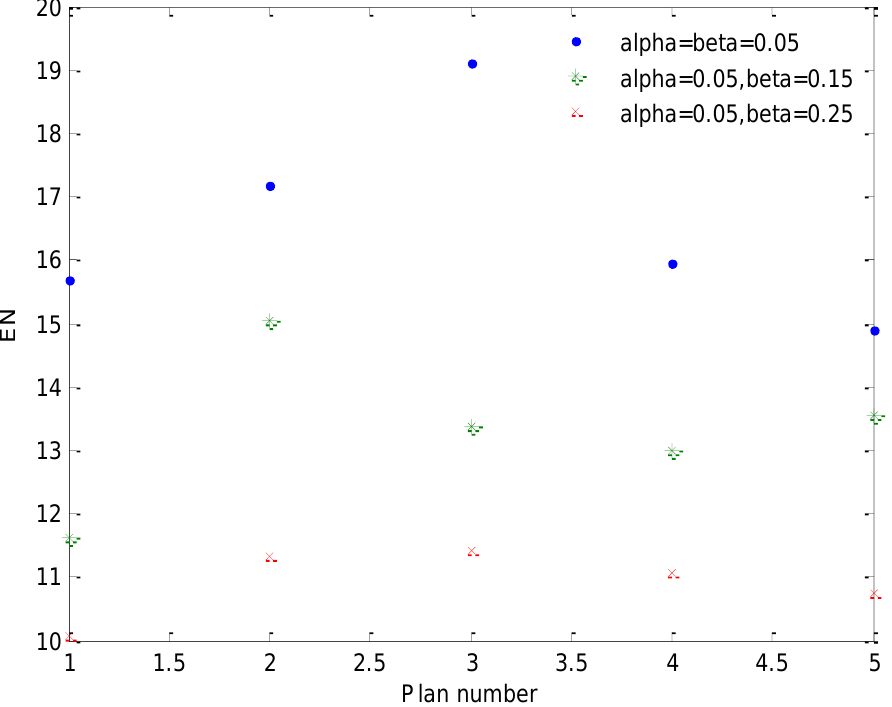
Fig. 1. The expected number of tests versus the plan number (Tables 4-6), p U =0.9, p L